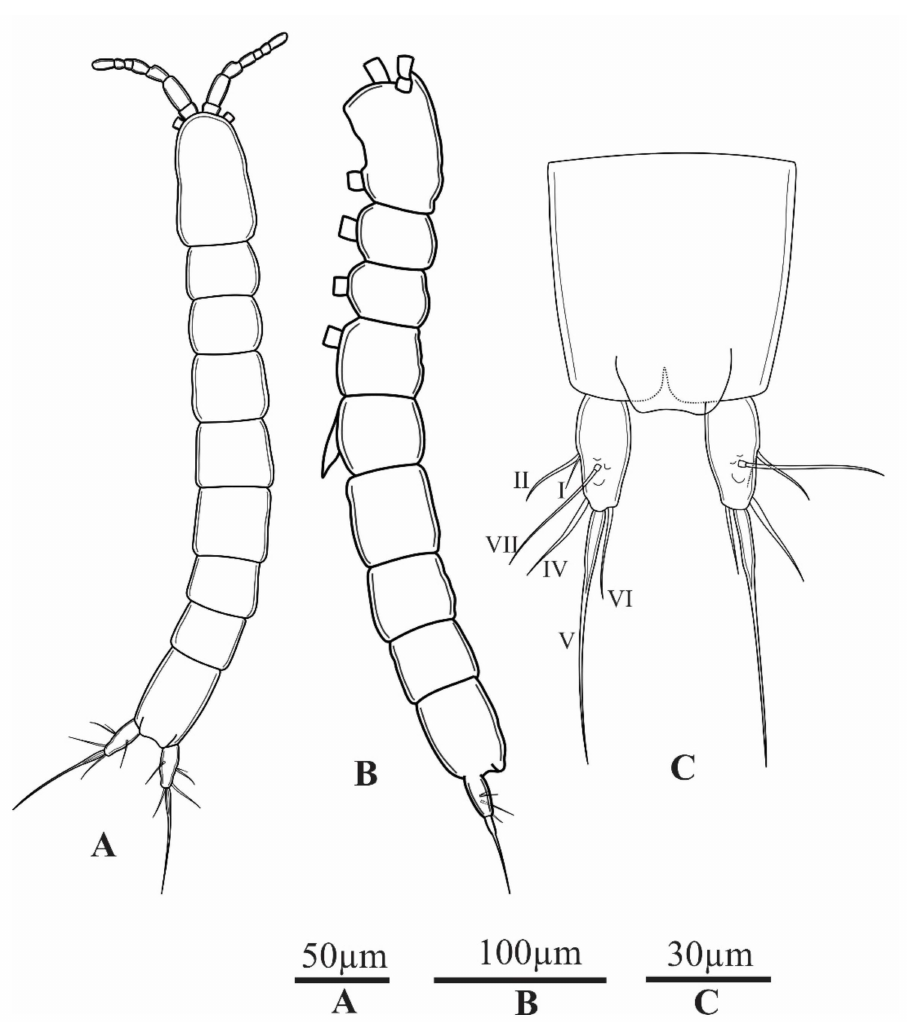
Figure 10. Parastenocaris vugiaensis sp. nov. holotype female. ( A ) habitus dorsal view; ( B ), habitus lateral view; ( C ), anal somite with furcal rami dorsal